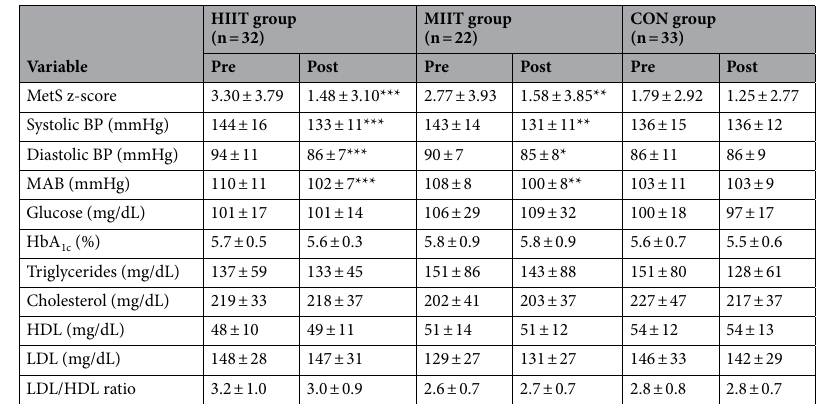
Table 5. Cardiometabolic risk variables pre- and post-intervention. Values are expressed as mean ± SD. HIIT high-intensity interval training group, MIIT moderate-intensity interval training group, CON control group, BP blood pressure, MAB mean arterial blood pressure, HbA 1c glycosylated hemoglobin A 1c , HDL high-density lipoprotein cholesterol, LDL low-density lipoprotein cholesterol. *( p < 0.05), **( p < 0.01), ***( p < 0.001), significantly different from pre-intervention.